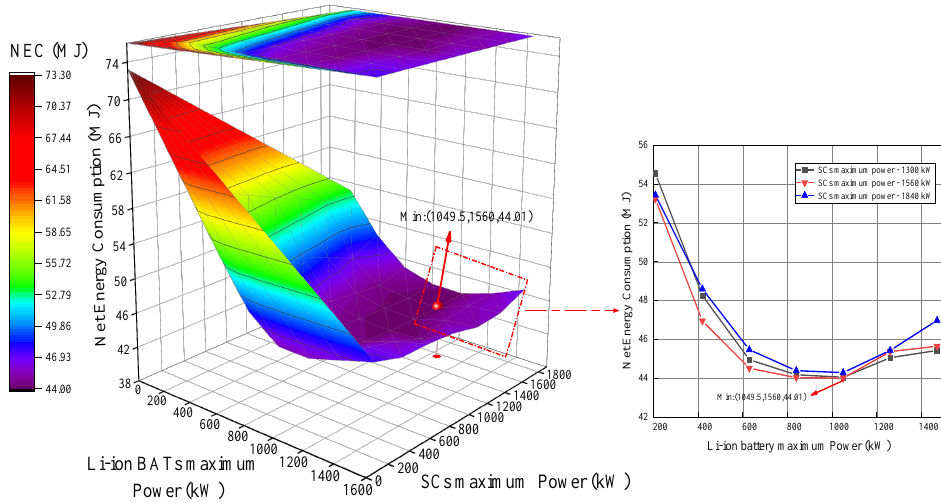
Figure 8. The NEC for different maximum power of on-board HESDs under varying capital cost con-